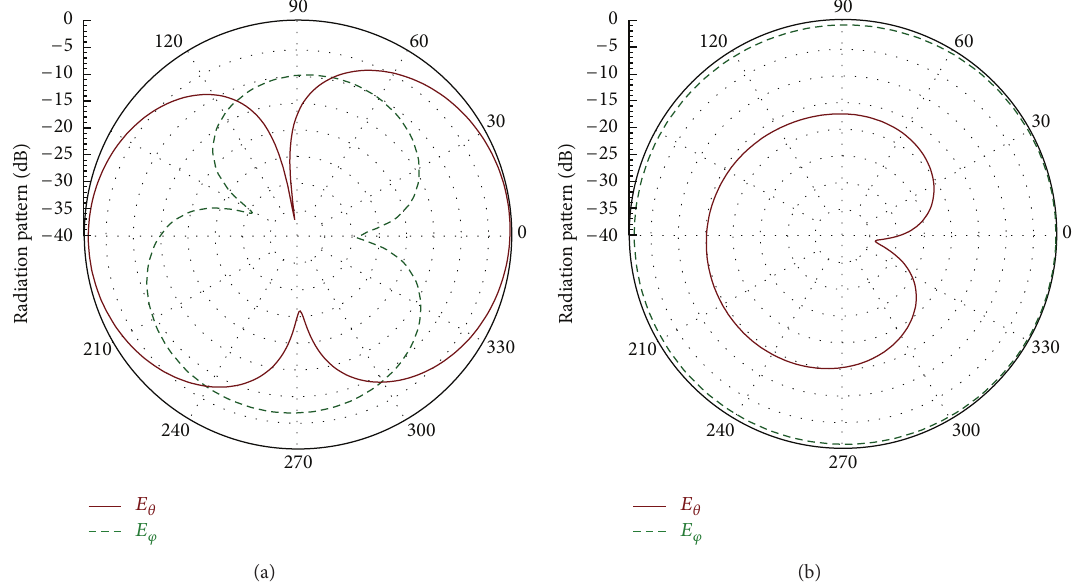
Figure 17: Simulated radiation patterns ( 𝐸 𝜃 and 𝐸 𝜑 components normalized to the electric field amplitude at 𝜃 = 0 ) for the proposed dual- band L-shape PIFA at 670 MHz: (a) 𝜑 = 45 ∘ plane; (b) 𝜑 = −45 ∘ plane.